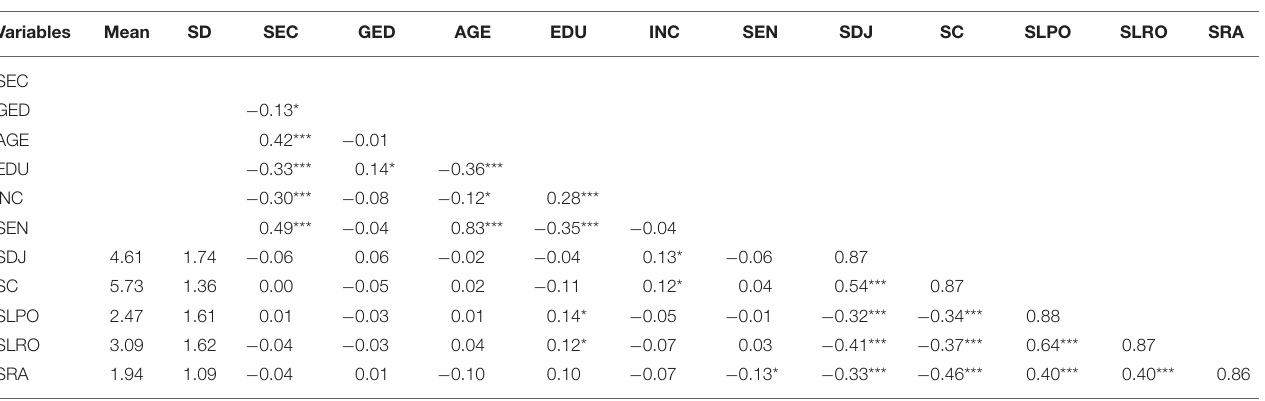
TABLE 3 | Mean, SD, and correlation matrix and square root of AVEs of the study variables. Variables